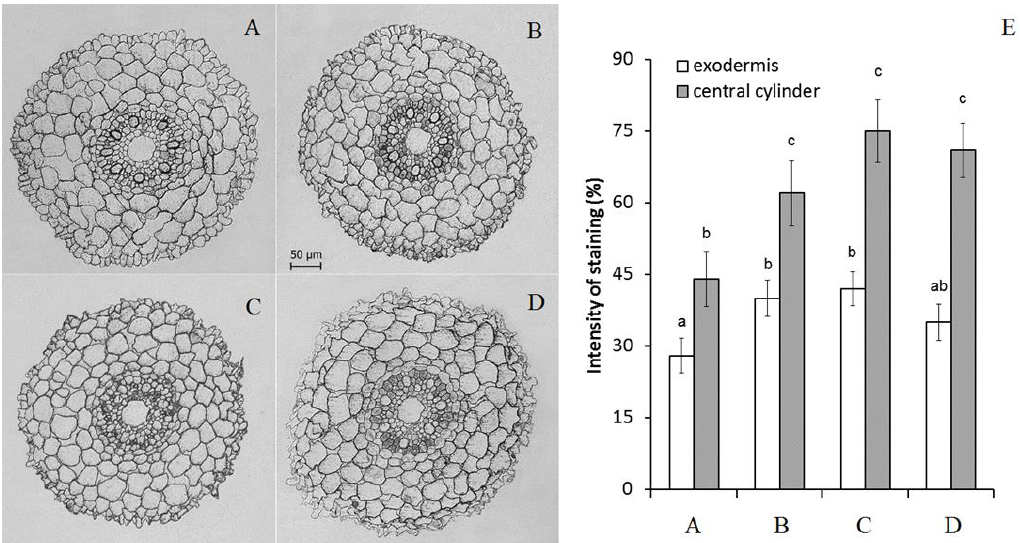
Figure 2. Immunolocalization of ABA ( A – D ) and intensity of staining for ABA of exodermis and central cylinder ( E ) (means ± SE, arbitrary units, maximal staining taken as 100%, minimal as 0%) in root sections untreated ( A ), treated with 10 μM ABA ( B ) and its combination with 10 μM diphenylene iodonium chloride ( C ) and 10 mM ascorbic acid ( D ). Data represent the mean ± S.E. ( n = 50) of arbitrary units; maximal staining was taken for 100%, and minimal staining was 0%. Significantly different means for each variable are labelled with different letters ( p ≤ 0.05, LSD test).